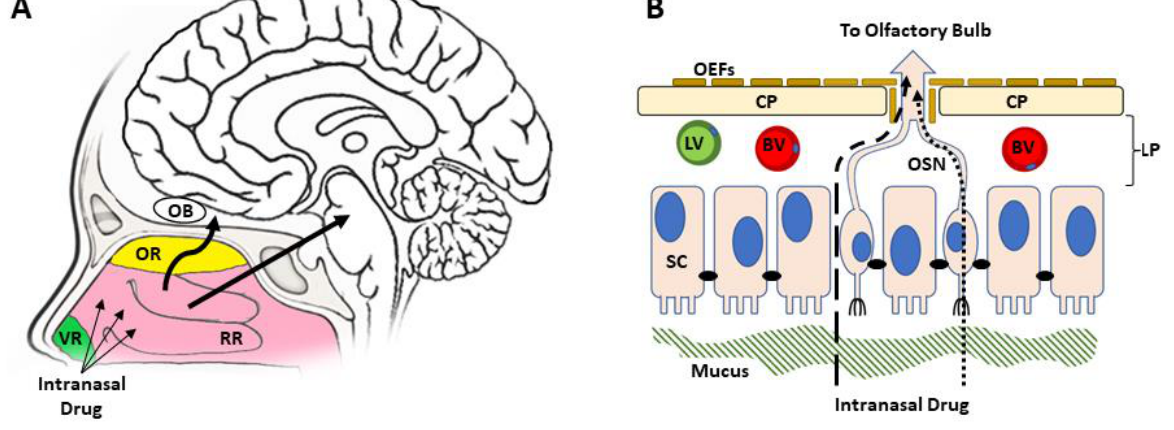
Figure 1. Anatomy and histology of the nasal cavity, epithelium, and transport pathway to the CNS. ( A ) Drugs administered to the nasal cavity cross the epithelium in either the superior olfactory region (OR) and move along the olfactory nerve (left arrow) to the olfactory bulb (OB), or the lateral respiratory regions (RR) and the trigeminal nerve (right arrow) to the pons. ( B ) From the lamina propria (LP), drugs are transported to the CNS along the olfactory sensory neuron (OSN, left arrow) p through the cribriform place (CP). A similar process occurs along the trigeminal nerve. Drugs can also be lost to systemic absorption via lymphatics (LV) or vasculature (BV). The anterior vestibular region (VR) is minimally involved in the intranasal route to the brain.